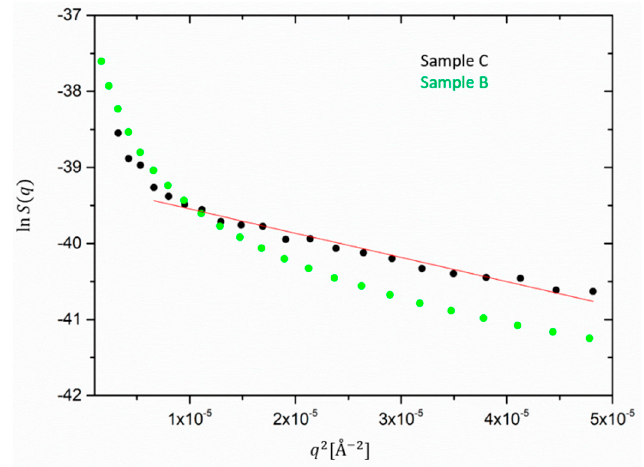
Figure 7. Guinier extrapolation for the silica cluster radius for sample C (black). The fit cannot be uniquely applied to sample B (green) due to the strong deviation from linearity.